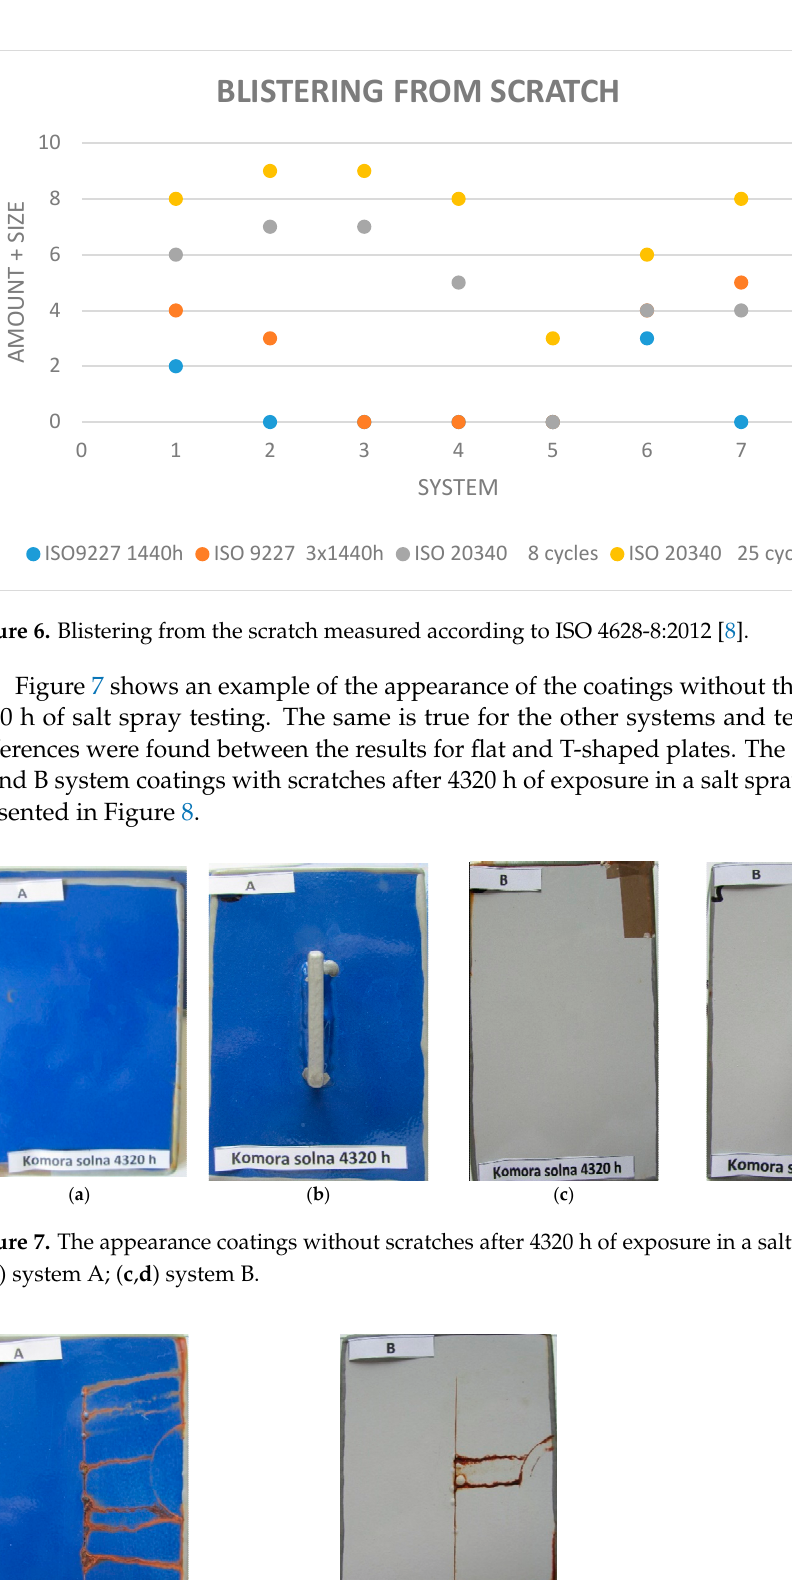
Figure 5. Rusting from the scratch measured according to ISO 4628 ‐ 8:2012 [8].